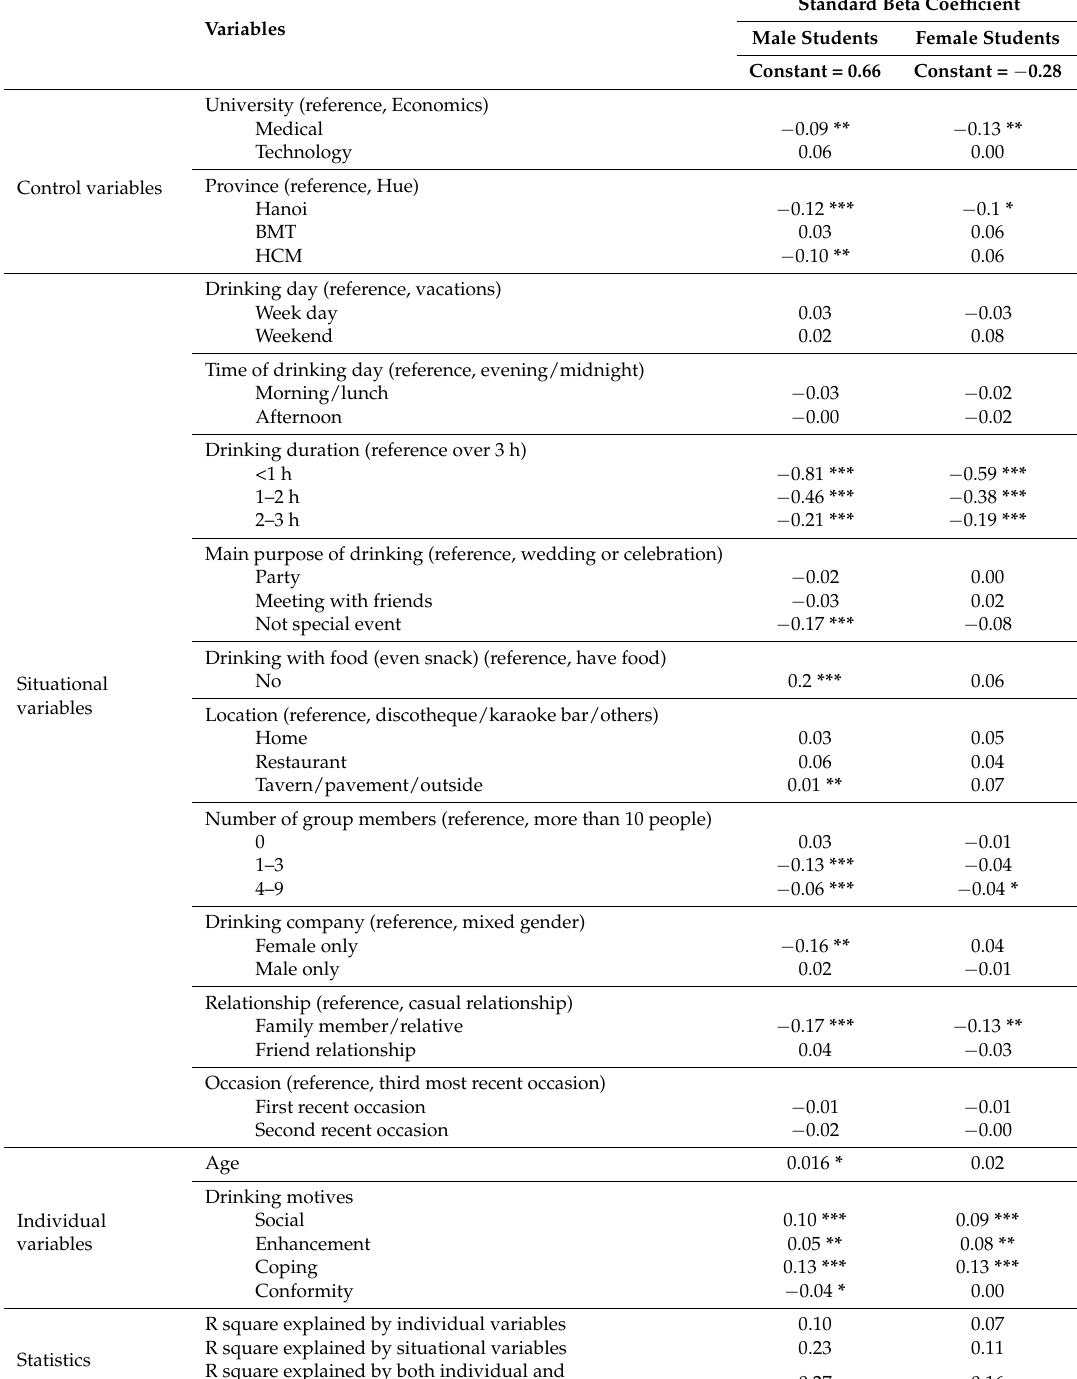
Table 3. Multilevel estimates for alcohol intake per